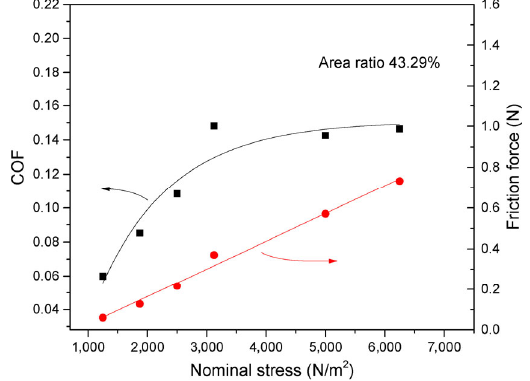
Fig. 9 Variation of the mean COF 0.05993, 0.08516, 0.10826, 0.14806, 0.1426, 0.14648 and the mean friction force 0.05993, 0.12774, 0.21652, 0.37015, 0.5704 N with increasing nominal stress when the area ratio was 43.29%.